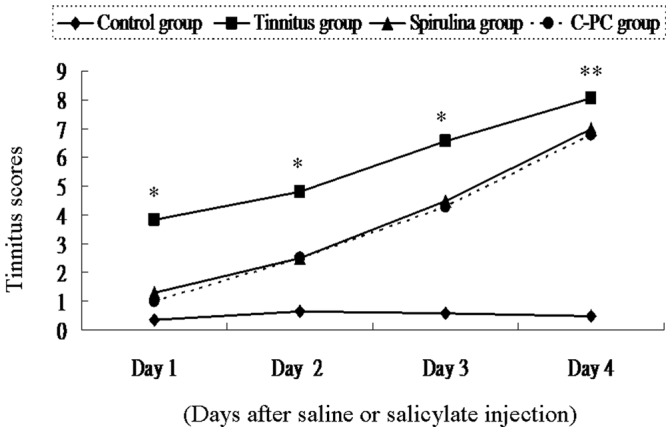
The tinnitus scores of four groups after intraperitoneal saline or salicylate injection.The tinnitus scores were significantly higher in the salicylate group than the control group on each day. In addition, the tinnitus scores of the Spirulina group and C-PC group were significantly lower than those of the salicylate group on each day (*p<0.001 at days 1, 2, and 3 for both groups; **p = 0.037 and 0.005 on day 4, respectively).